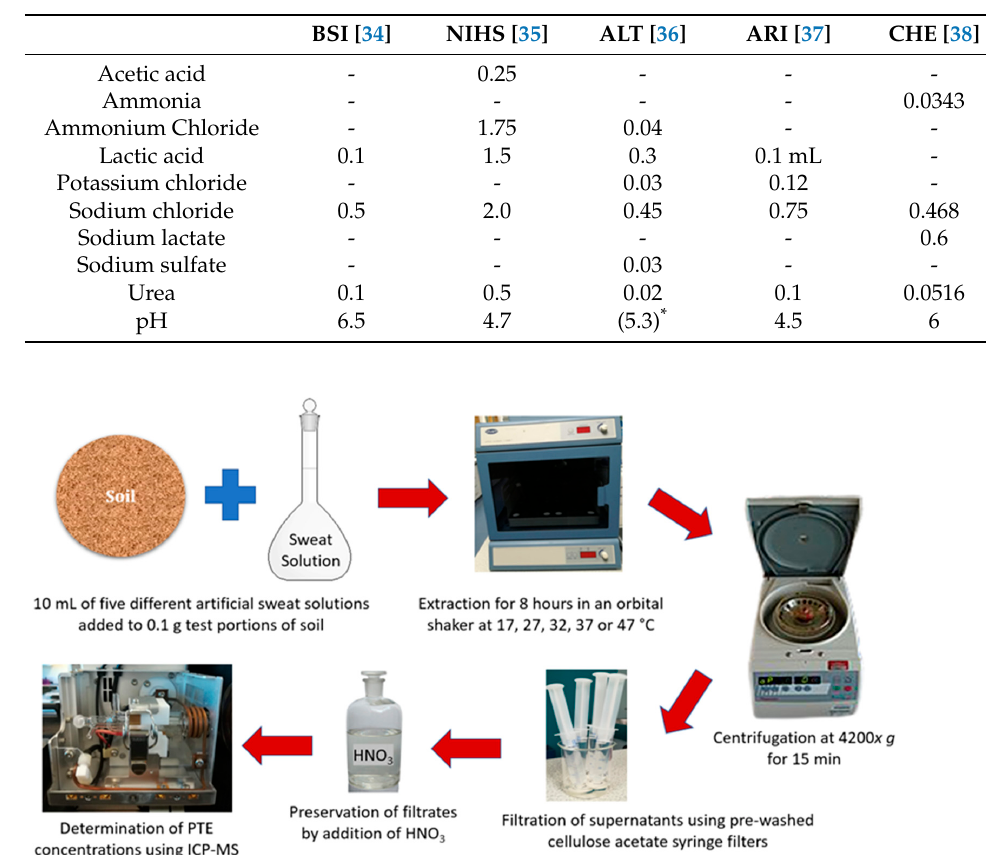
Figure 1. Flowchart illustrating the dermal bioaccessibility test methodology.